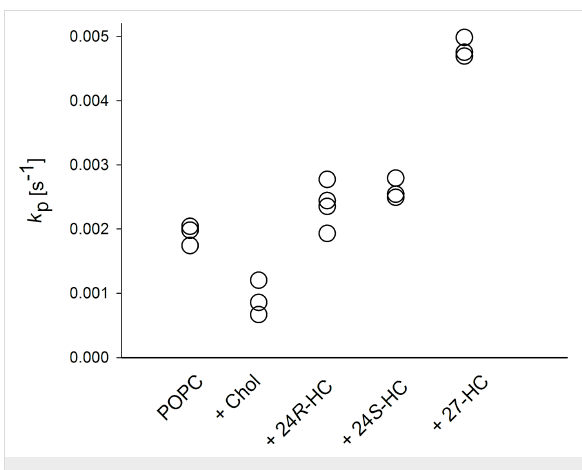
Figure 3: Rate constants for the permeation of dithionite across LUV membranes composed of POPC in the absence or in the presence of cholesterol or (24 R )-hydroxycholesterol (24 R -HC), (24 S )-hydroxycho- lesterol (24 S -HC) or 27-hydroxycholesterol (27-HC) (molar ratios 0.8:0.2) at 37 °C. All single values of the rate constants are shown which were determined from independent measurements.